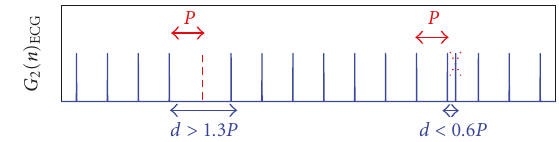
Figure 4: Removal of the erroneous peaks and addition of the missing positions.